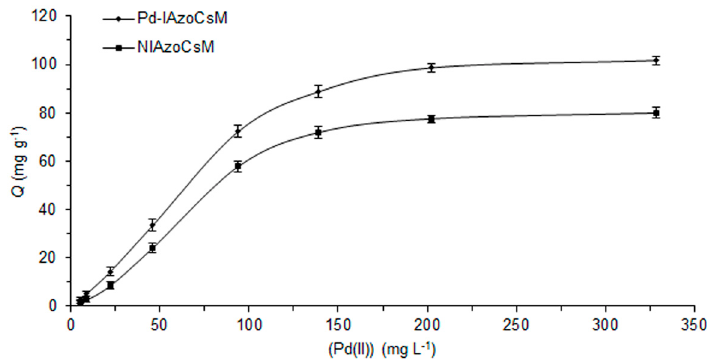
Figure 9. Binding isotherm of the imprinted and non-imprinted membranes.